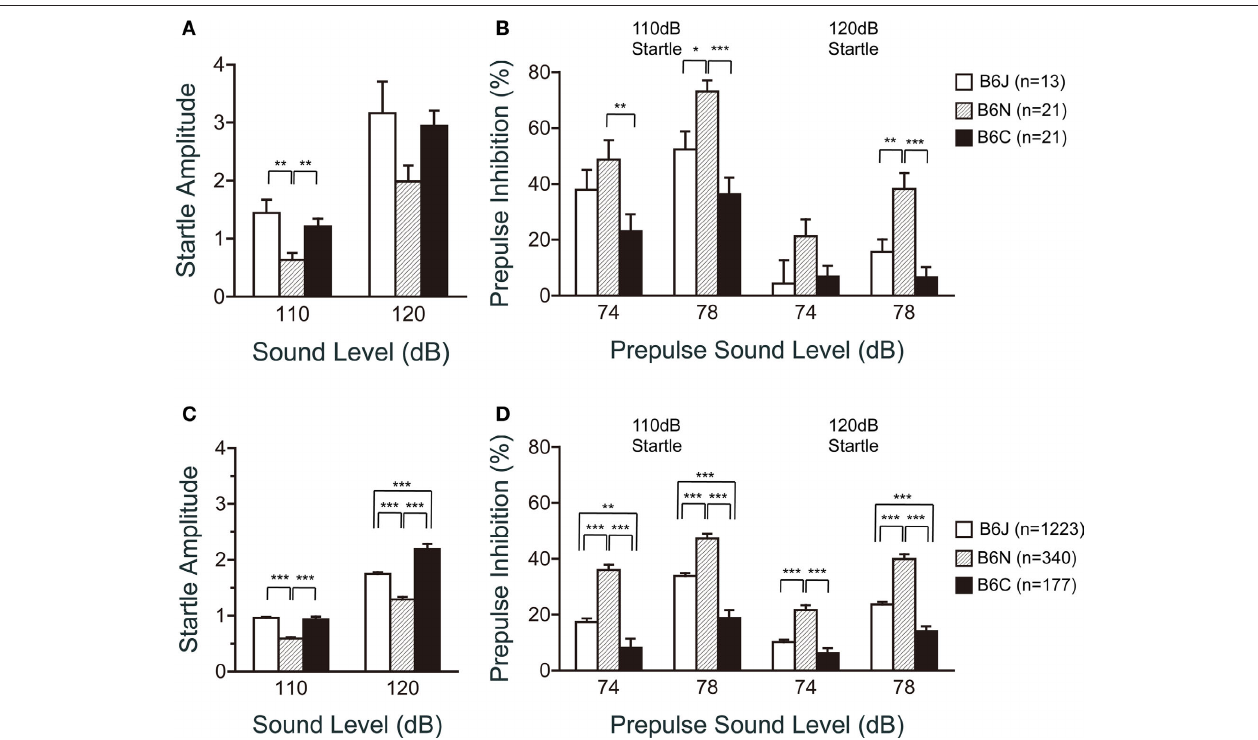
startle amplitude. (B,D) Prepulse inhibition for the 74 and 78 dB prepulse sound level. C57BL/6N showed the highest prepulse inhibition. * p < 0.05, ** p < 0.01, *** p < 0.0001. Error bars indicate SEM.